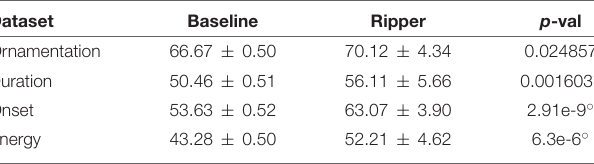
TABLE 8 | Accuracy of models trained with selected features (Mean ± Std